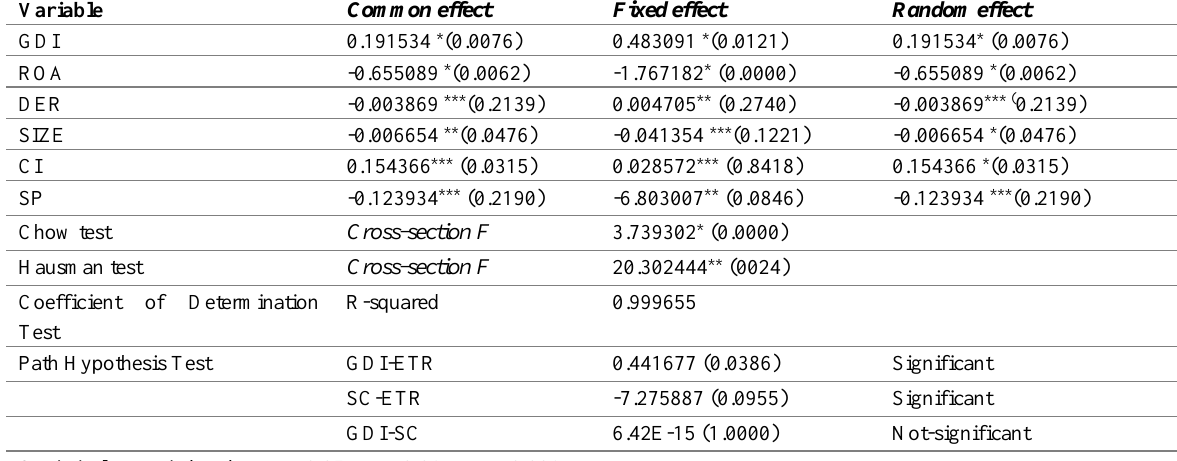
Table 4: Regression